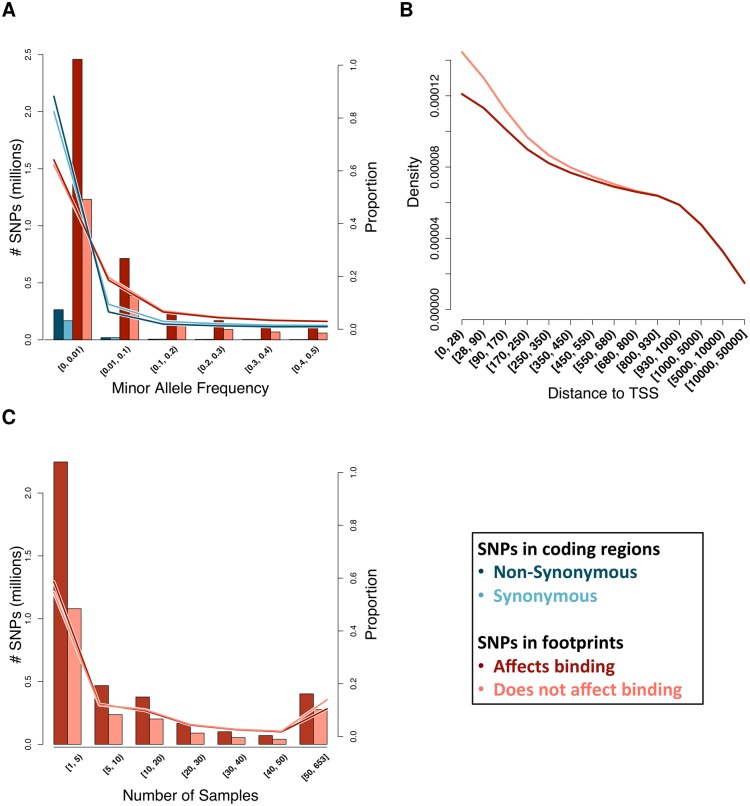
Characterization of SNPs in DNase I footprints.(A) Comparison of the minor allele frequency of SNPs predicted to affect binding or to be silent, showing both counts (bars) and proportions within SNP category (lines). Minor allele frequency at coding SNPs (from 1KG), separated into non-synonymous and synonymous, is shown for comparison. MAF is in bins of 10%, with the exception of rare (MAF < 1%) SNPs. (B) Proportion of SNPs at increasing distance from the nearest transcription start site (TSS) up to 50Kb. Distance is absolute distance, regardless of direction (up- or downstream) from TSS. (C) Stratification of footprint-SNPs by the number of tissues for which the footprint was predicted active, showing both counts (bars) and proportions within SNP category (lines). Number of tissues is binned by 5 or 10 until 50, where the remainder is binned.